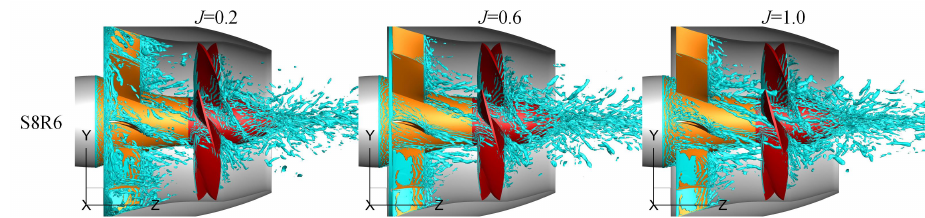
Figure 25. Interaction between the blade wake vortices of the rotor and stator of PJP model